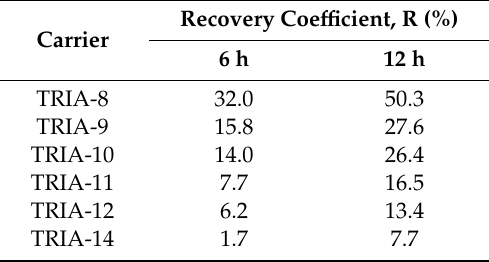
Table 6. Recovery coefficient (R, %) of Cu(II) ions after 6 h and 12 h (R, %) depending on the length of the alkyl substituent.